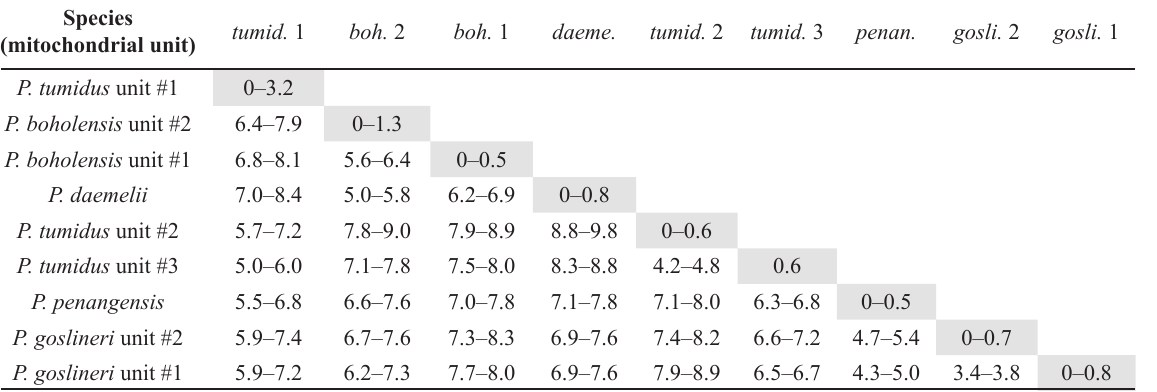
Table 2. Pairwise genetic distances between individual sequences within and between mitochondrial units, based on our data set of 159 COI sequences (Table 1). Ranges of minimum to maximum distances are indicated (as percentages). For instance, within P. tumidus (Semper, 1880) unit #1, individual sequences are between 0 and 3.2% divergent; individual sequences between P. tumidus unit #1 and P. boholensis gen. et sp. nov. unit #2 are minimally 6.4% and maximally 7.9% divergent; also, overall, the distance gap between P. tumidus unit #1 and the eight other mitochondrial units is between 3.2% (the maximum intra-unit distance within P. tumidus unit #1) and 5% (the minimum distance between P. tumidus unit #1 and P. tumidus unit #3). The data from this table are illustrated in Figure 5 to help visualize the large gap between intra-specific and inter-specific